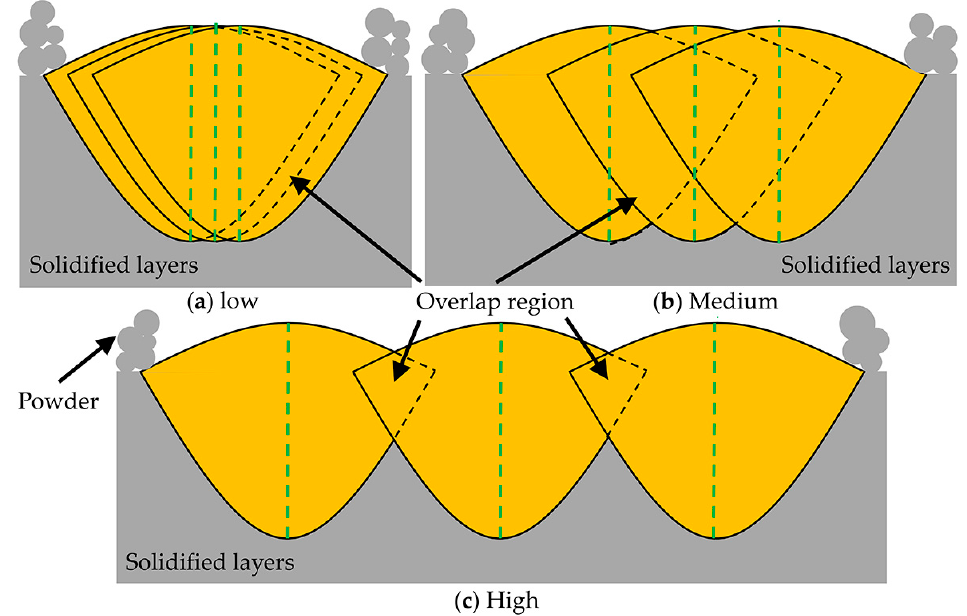
Figure 5. Illustration of different hatch spacings at fixed laser power and scanning speed.